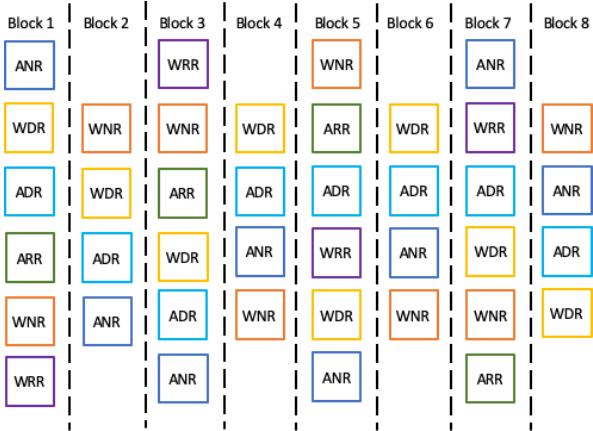
Figure 1. Conceptual diagram for the experimental design of the Silver Plains warming experiment. Each block contains a warmed and unwarmed plot with no species removed (WNR and ANR, re- spectively); a warmed and unwarmed plot with the dominant species removed (WDR and ADR, respectively); and in every second block, i.e. in four blocks total, there is a warmed and unwarmed plot with random biomass removal (WRR and ARR,